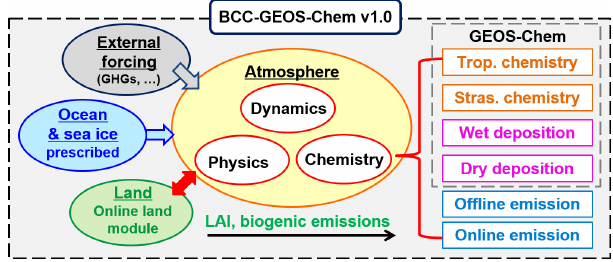
Figure 1. Schematic diagram of the BCC-GEOS-Chem v1.0 model framework.